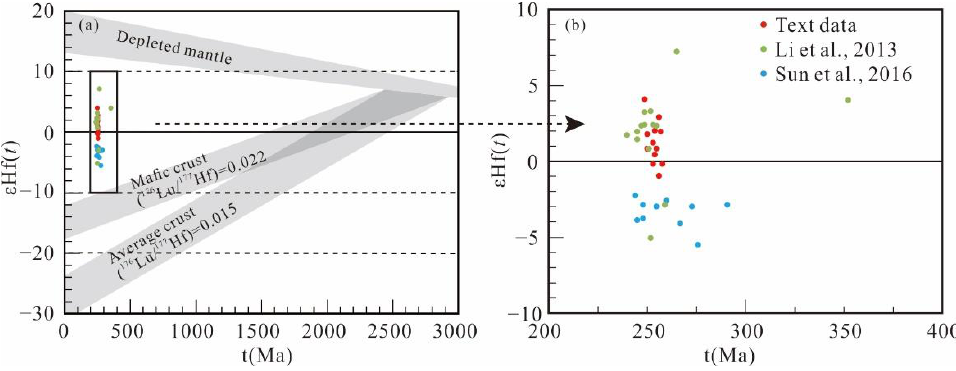
Figure 8. εHf( t ) versus age diagram ( a , b ) (Base image according to [64]). The samples from Li et al. [17] and Sun et al. [44] are granite porphyries not far from the study area along the Ailaoshan oro- genic belt.